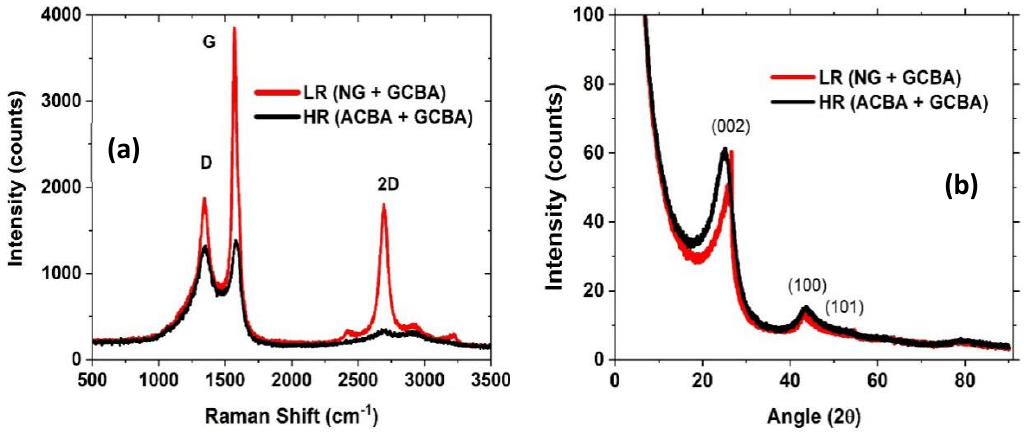
Figure 4. ( a ) Raman spectra illustrating the control of 2D nanographene material revealed by the graphene signature peak at ~2700 cm − 1 . The overall graphitic content varies concurrently, as seen from the relative intensities of the D and G peaks. ( b ) X-ray diffraction (XRD) pattern of LR and HR produced carbons.